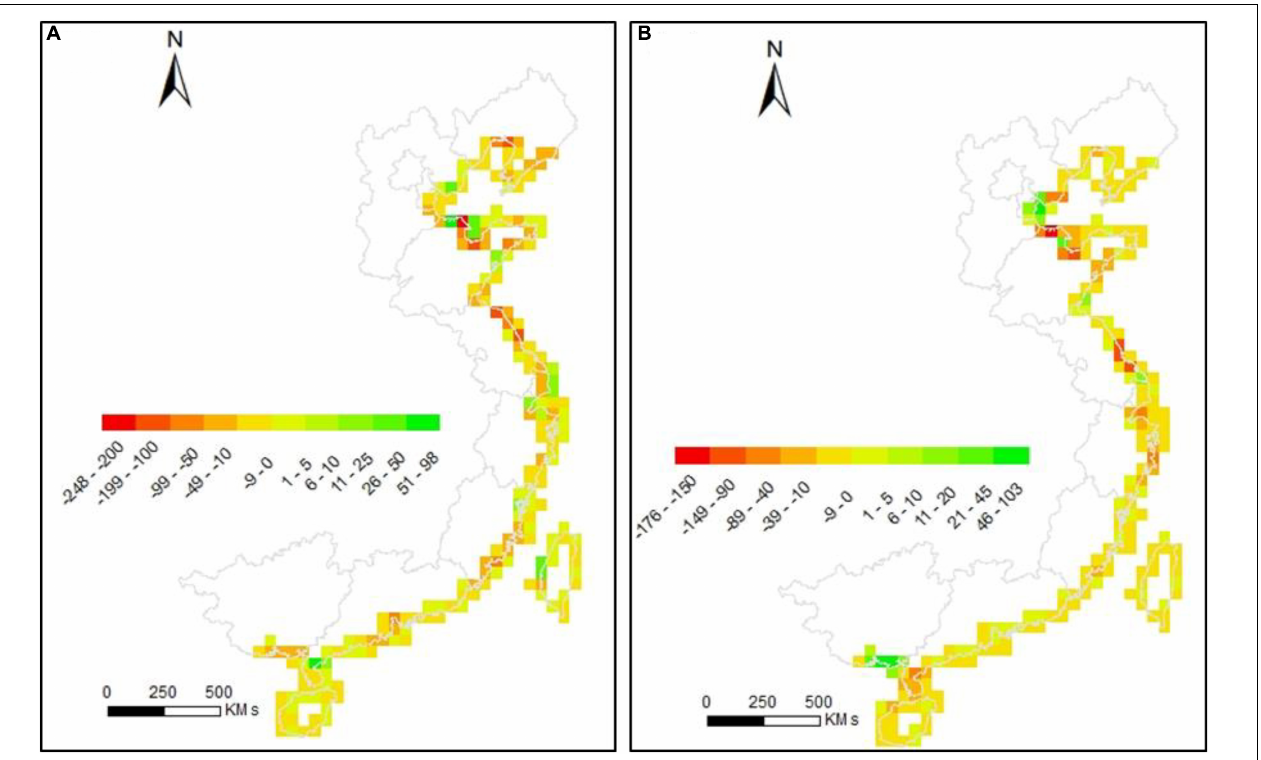
FIGURE 6 | Area change of intertidal wetland from the 1970s to 1995 (A) , and from 1995 to 2015 (B) at a spatial resolution of 50 km.